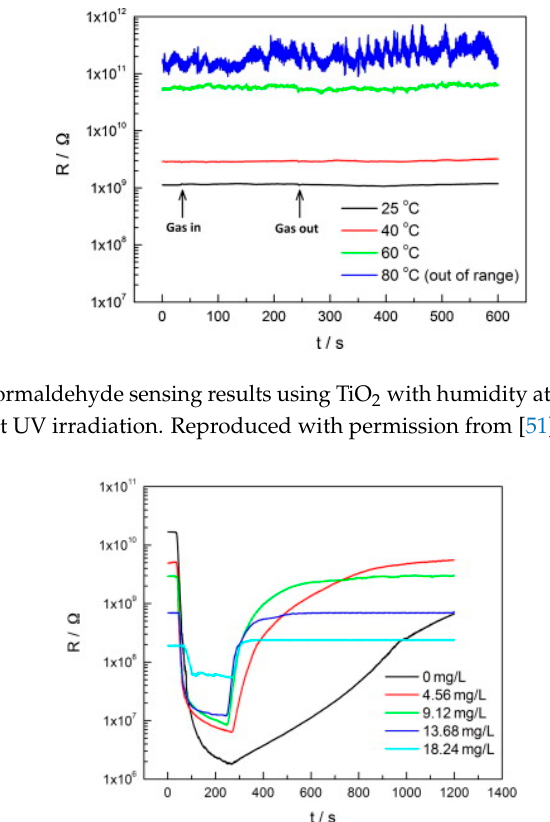
Figure 14. Conductance response of SnO 2 towards 100 ppm NO 2 with illumination at different wavelengths. Reproduced with permission from [50].